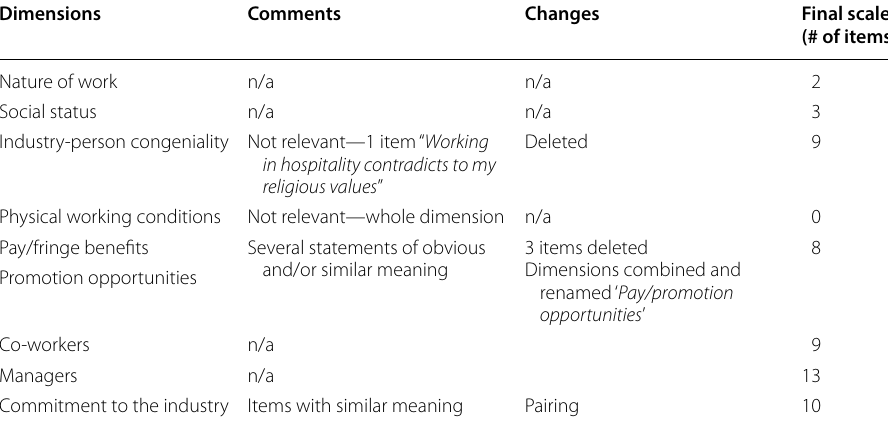
Table 2 Summary of changes to the modified scale